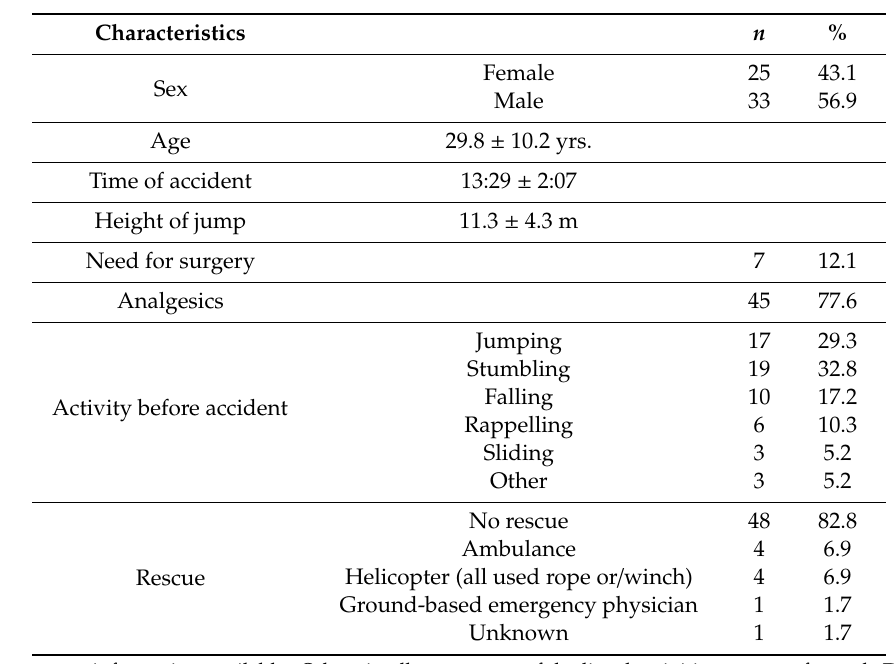
Table 5. Characteristics of canyoning emergencies treated at Innsbruck Medical University Hospital from November 1, 2005 to October 31,